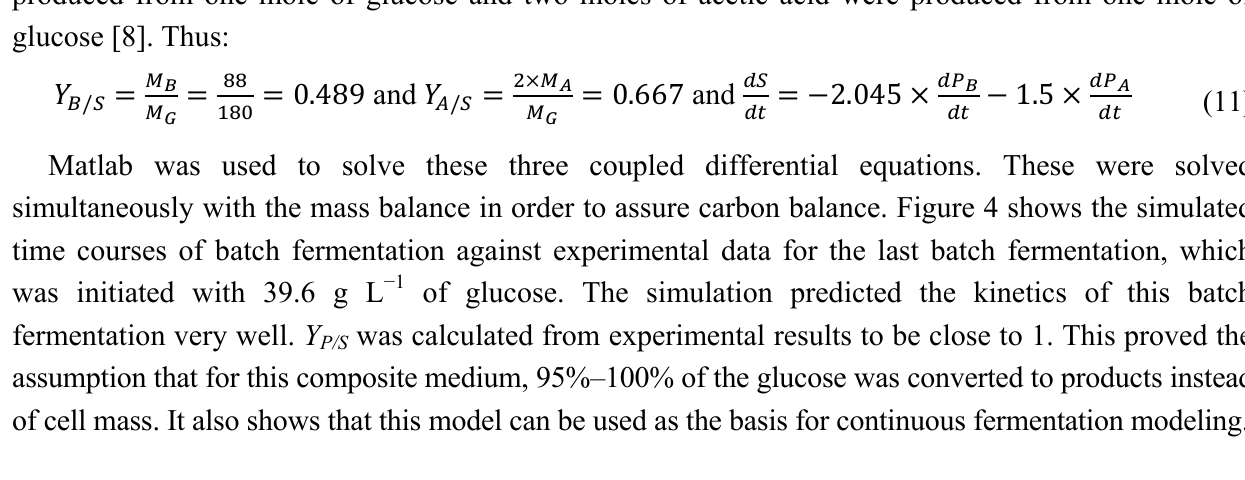
Figure 4. Batch fermentation simulation and experimental data with Clostridium tyrobutyricum at initial glucose concentration of 39.6 g L − 1 and pH of